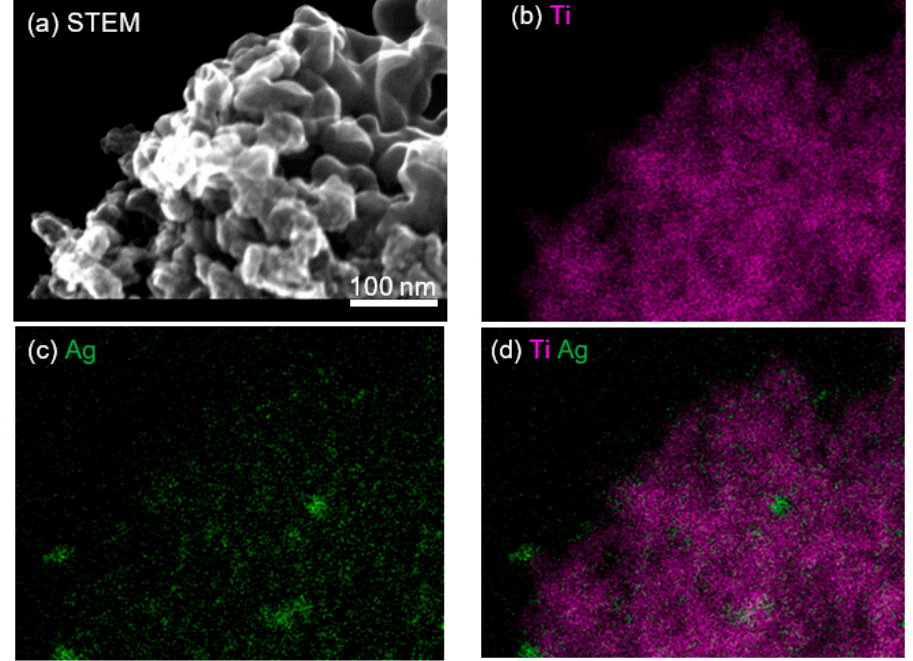
Figure 4. STEM ( a ) and EDS (Ti- ( b ), Ag ( c ) and merge of Ti and Ag ( d )) images of Ag 2 O/ST01.